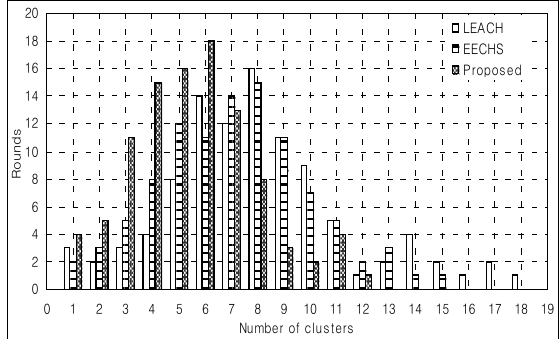
Fig. 3. The distribution of the numbers of clusters in each